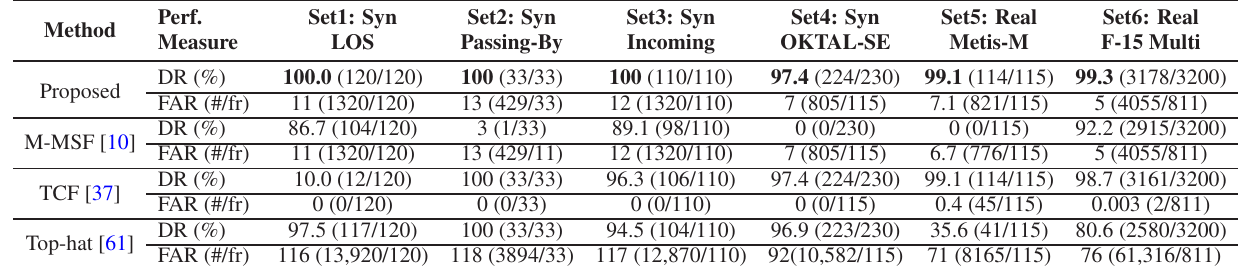
Table 1. Statistical performance comparisons of the small infrared target detection methods (DR: detection rate; FAR: number of false alarms per frame; PE: position error).